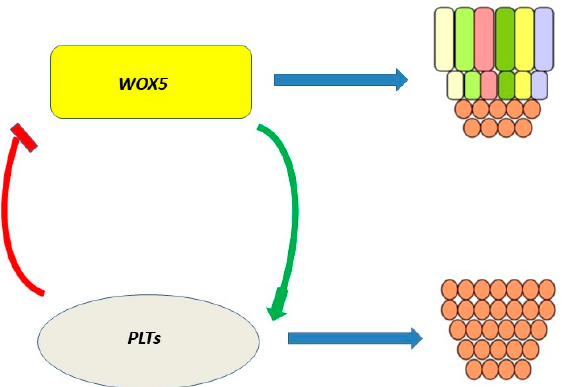
Figure 6. Relationship between PLTs and WOX5 . High WOX5 expression causes stem cell prolifera- tion, and its loss causes their